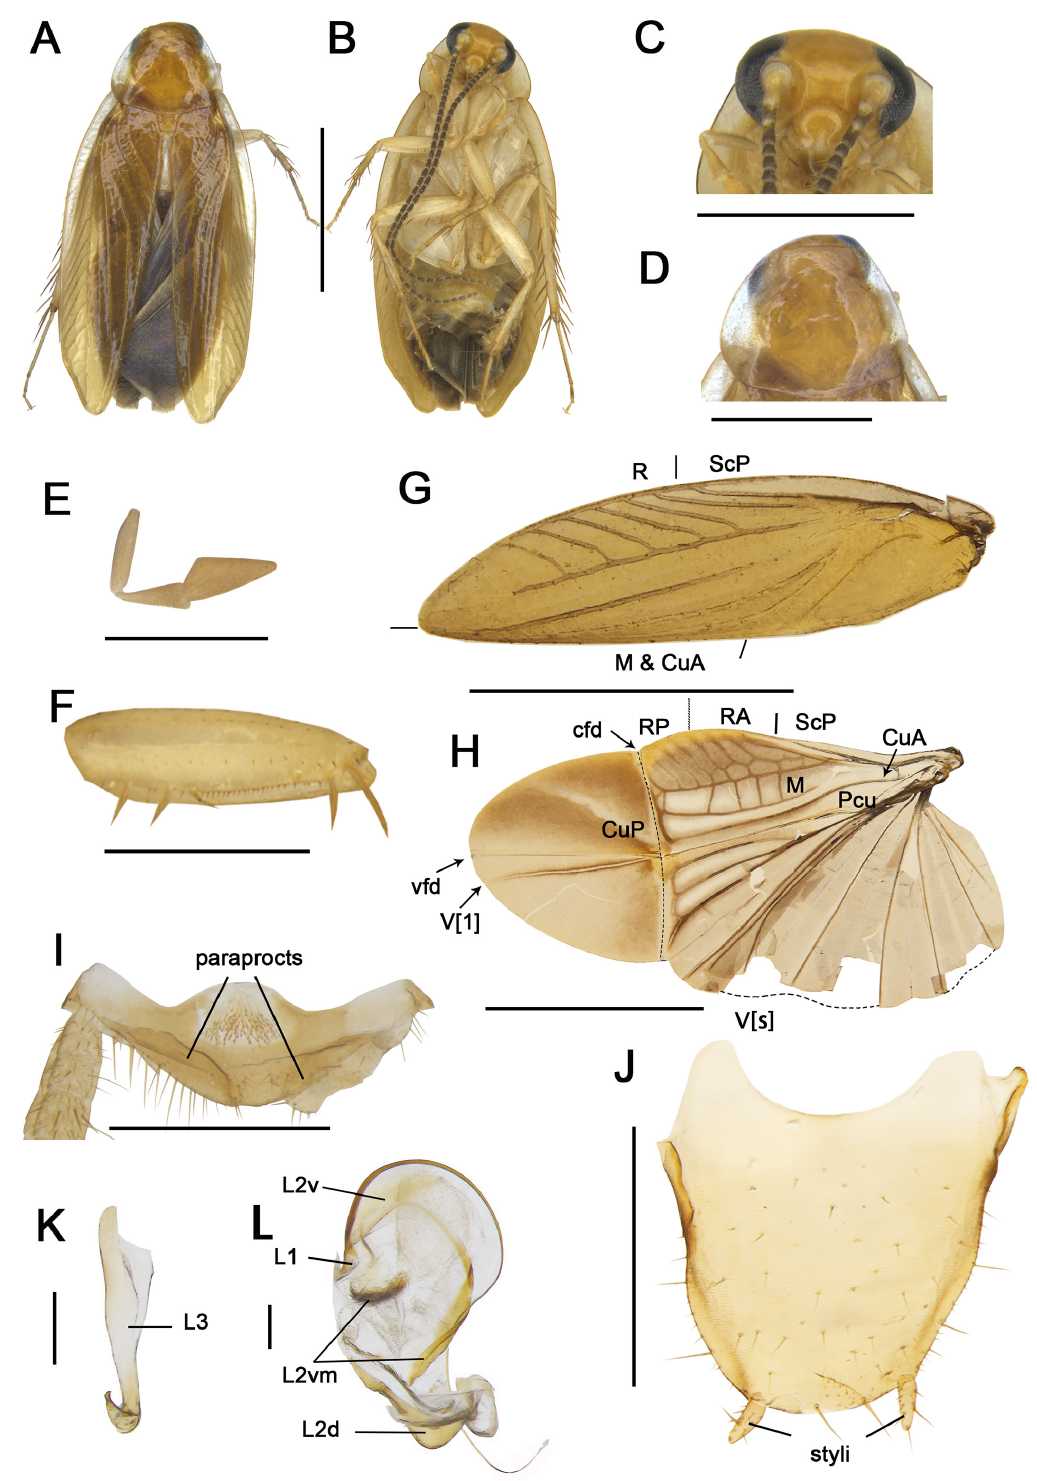
Fig. 4. Anaplecta arcuata Deng & Che sp. nov., holotype, ♂ (SWU). A . Habitus, dorsal view. B . Habitus, ventral view. C . Head, ventral view. D . Pronotum, dorsal view. E . Maxillary palp. F . Front femur, ventral view. G . Tegmina. H . Wings. I . Supra-anal plate, dorsal view. J . Subgenital plate, ventral view. K . Hook, ventral view. L . Left phallomere, ventral view. Scale bars: A–B, G–H = 2 mm; C = 1 mm; D–F, I–J = 0.5 mm; K–L = 0.1